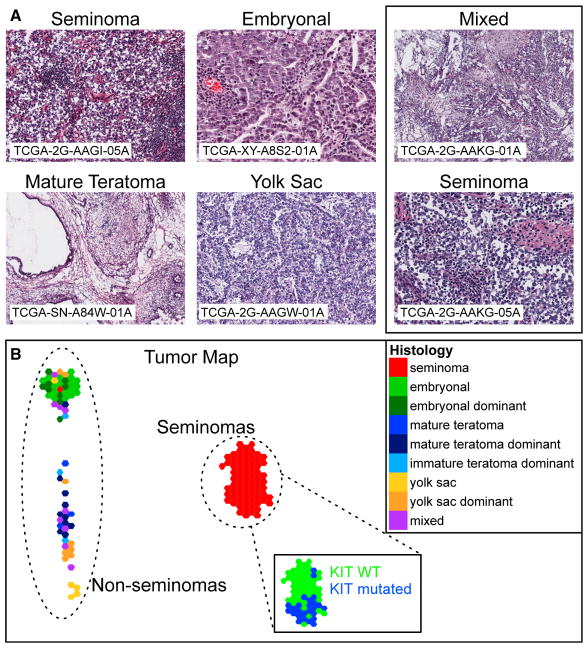
Histologic and Molecular Classification of TGCTs(A) Representative images of H&E-stained slides of frozen sections are shown for seminomas, EC, mature teratomas, and yolk sac tumors. Box at right shows two asynchronous primaries from the same patient. All images 100× magnification.(B) Tumor Map visual representation of molecular heterogeneity separating seminomas and NSGCTs. Samples are displayed as hexagons, and the spatial layout reflects sample groupings and molecular relations between samples. Samples are colored based on their histological classification. In the seminoma inset, samples are colored by KIT mutation status. KIT wild-type, green; KIT mutant, blue.See also Figures S1 and S5 and Tables S4, S5, S6, and S7.